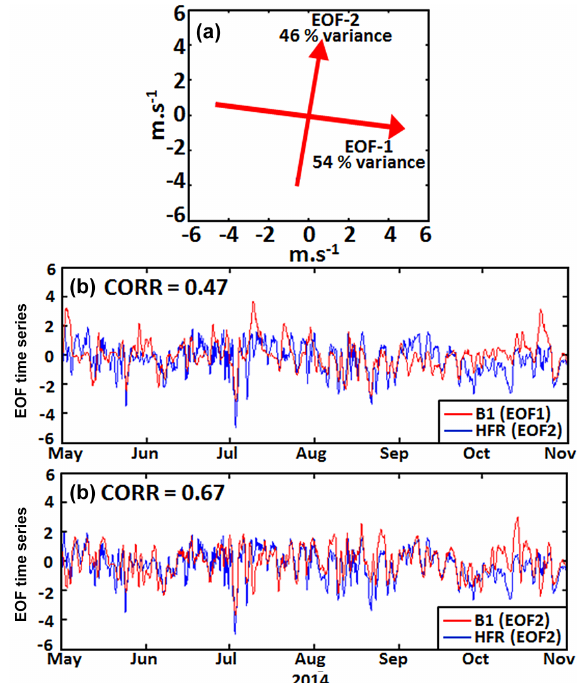
Figure 12. (a) Main axes of variability for hourly wind data reg- istered at the B1 buoy. (b) Principal components of the first EOF mode of wind (ms − 1 , in red) and the second EOF mode of radar currents (cms − 1 , in blue). (c) Principal components of the second EOF mode of wind (red) and the second EOF mode of radar cur- rents (blue). The amplitudes have been normalized by their respec- tive standard deviations and filtered with a 1-day running